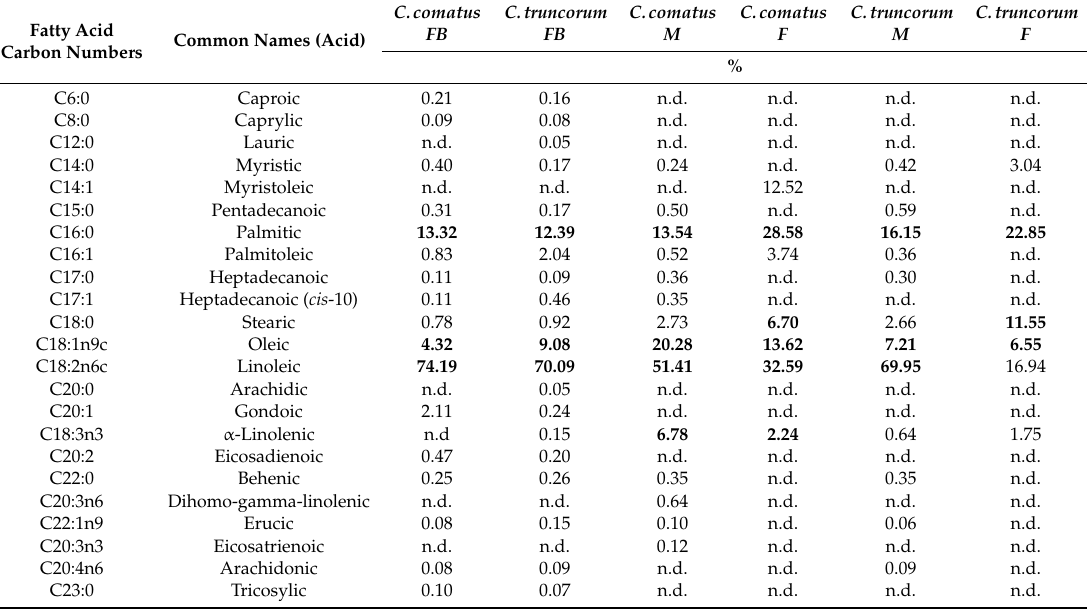
Table 3. The content of fatty acid compounds in the analysed samples (relative